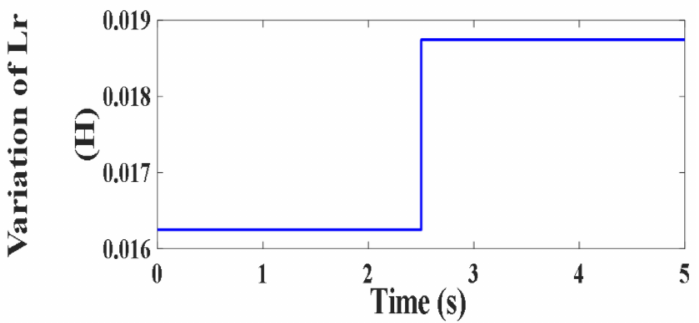
Figure 168. Variation of L r